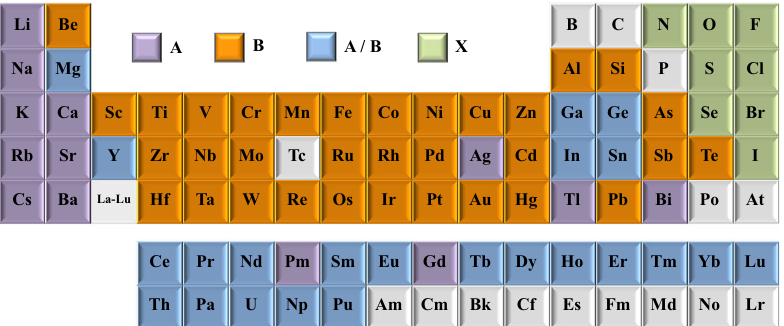
Fig. 4 The elements of the periodic table to form perovskites. Elements that have the probability of form the perovskite structure in the periodic